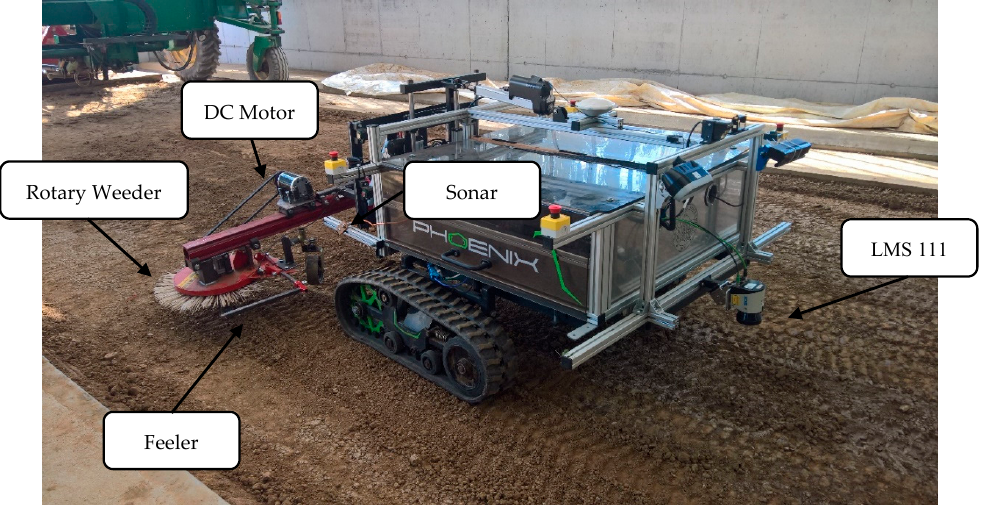
Figure 1. Autonomous robot called “phoenix” with attached rotary weeder implement and sensors.